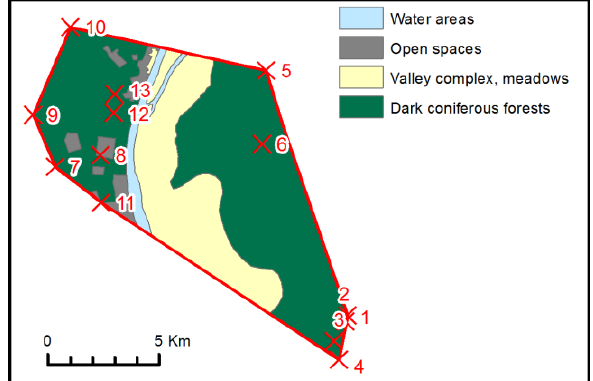
Figure 1. Distribution of the vegetation types on the ground test area. The numbers allocate sample plots positions on the ground test area that were used for direct terrestrial